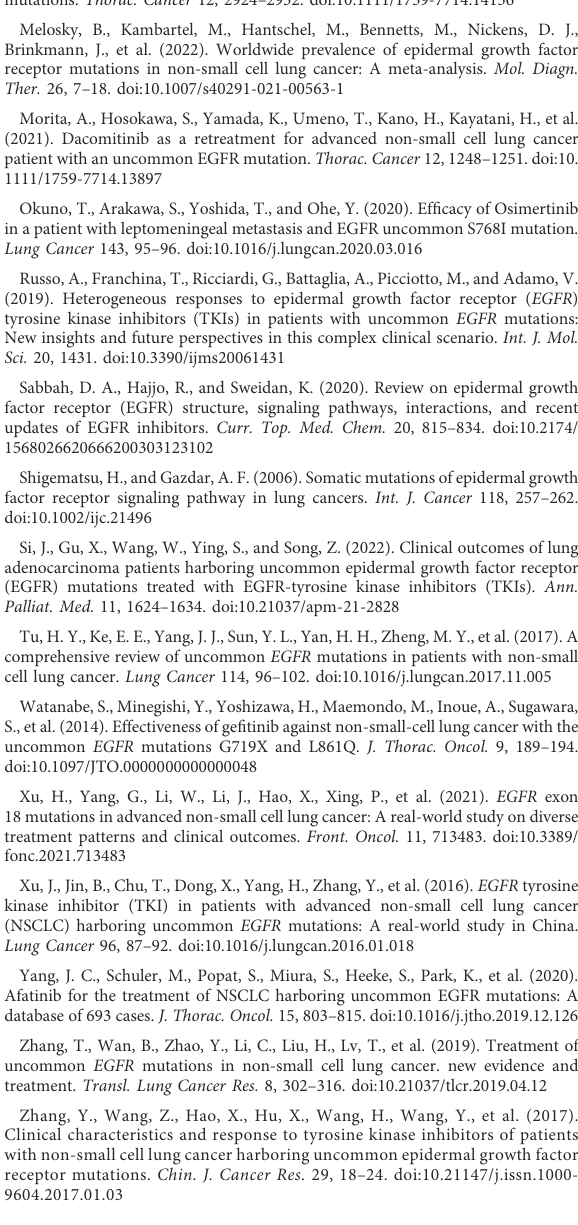
SUPPLEMENTARY FIGURE S1 Binding modes of different TKIs Afatinib (A) , Dacomitinib (B) , Osimertinib (C) , Almonertinib (D) , Furmonertinib (E) , and Pyrotinib (F) to S768I conformation. SUPPLEMENTARY FIGURE S2 Binding modes of different TKIs Afatinib (A) , Dacomitinib (B) , Osimertinib (C) , Almonertinib (D) , Furmonertinib (E) , and Pyrotinib (F) to L861Q